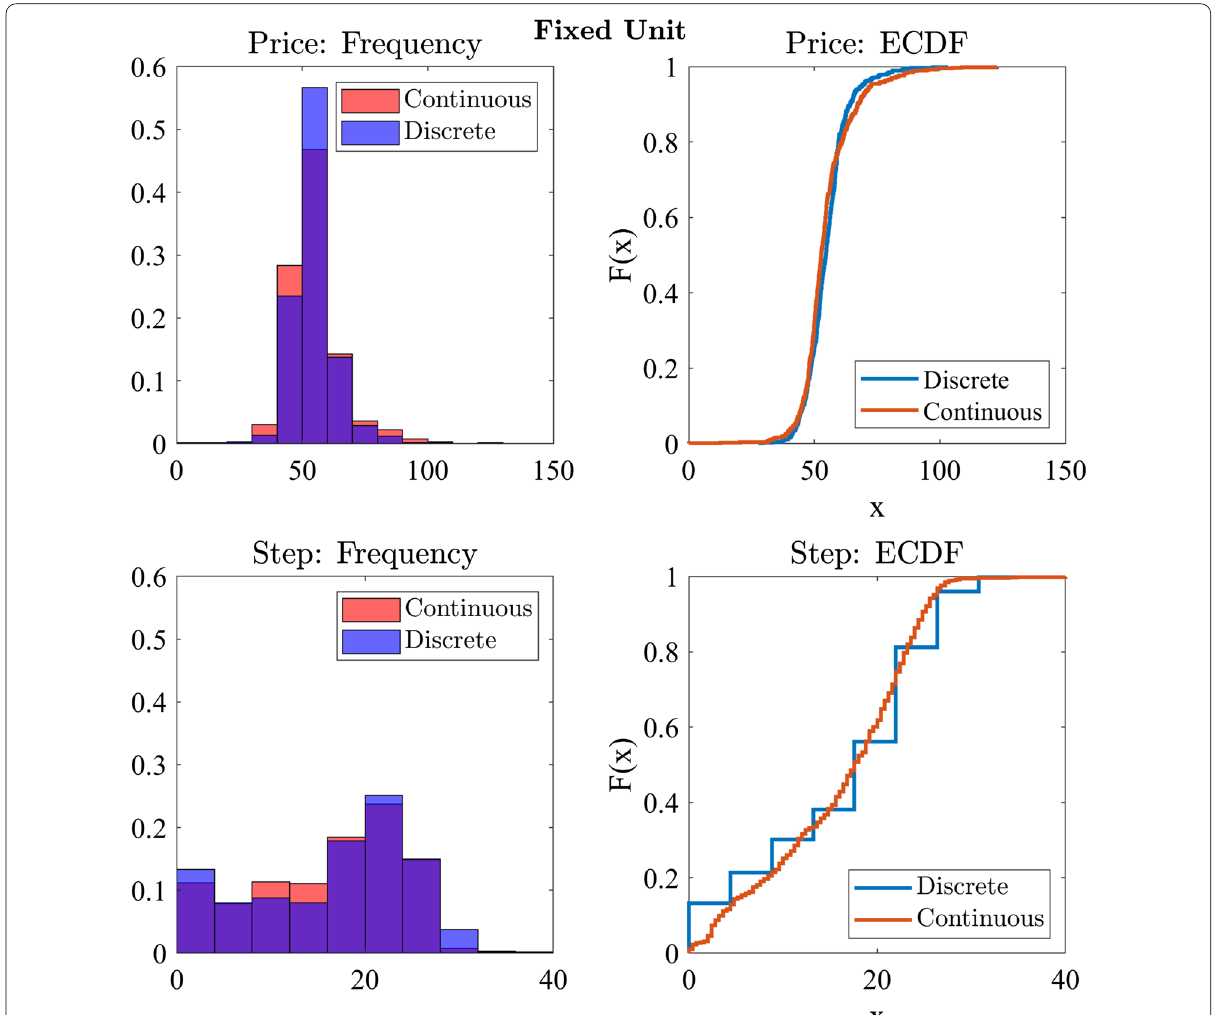
Fig. 6 Frequency distributions and empirical cumulative distribution functions for price and step of the winning bid across continuous and discrete price change